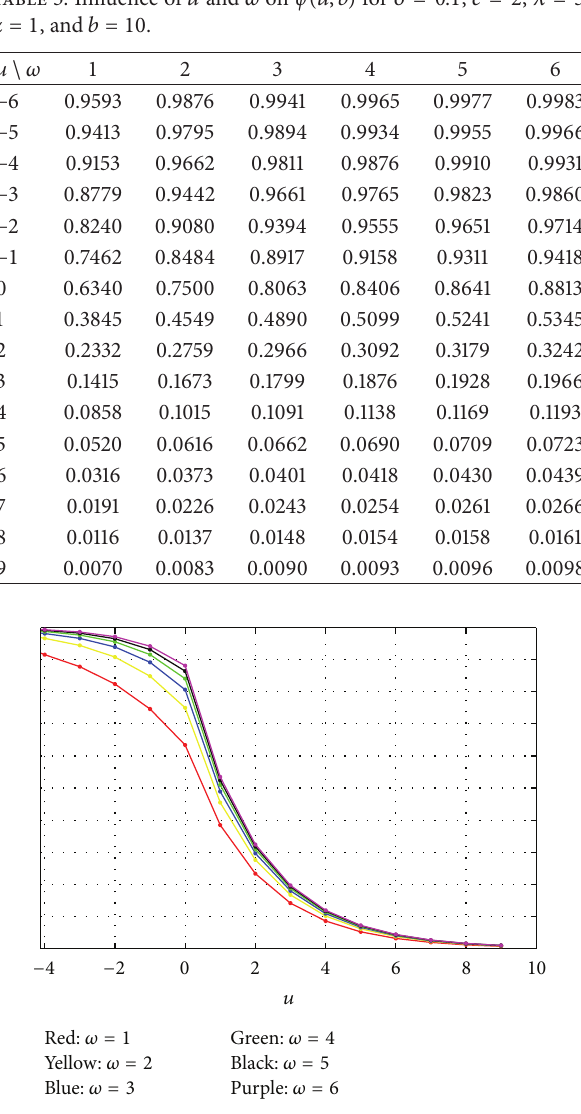
Figure 3: The bankruptcy probability 𝜓(𝑢,𝑏) when 𝑏 = 10